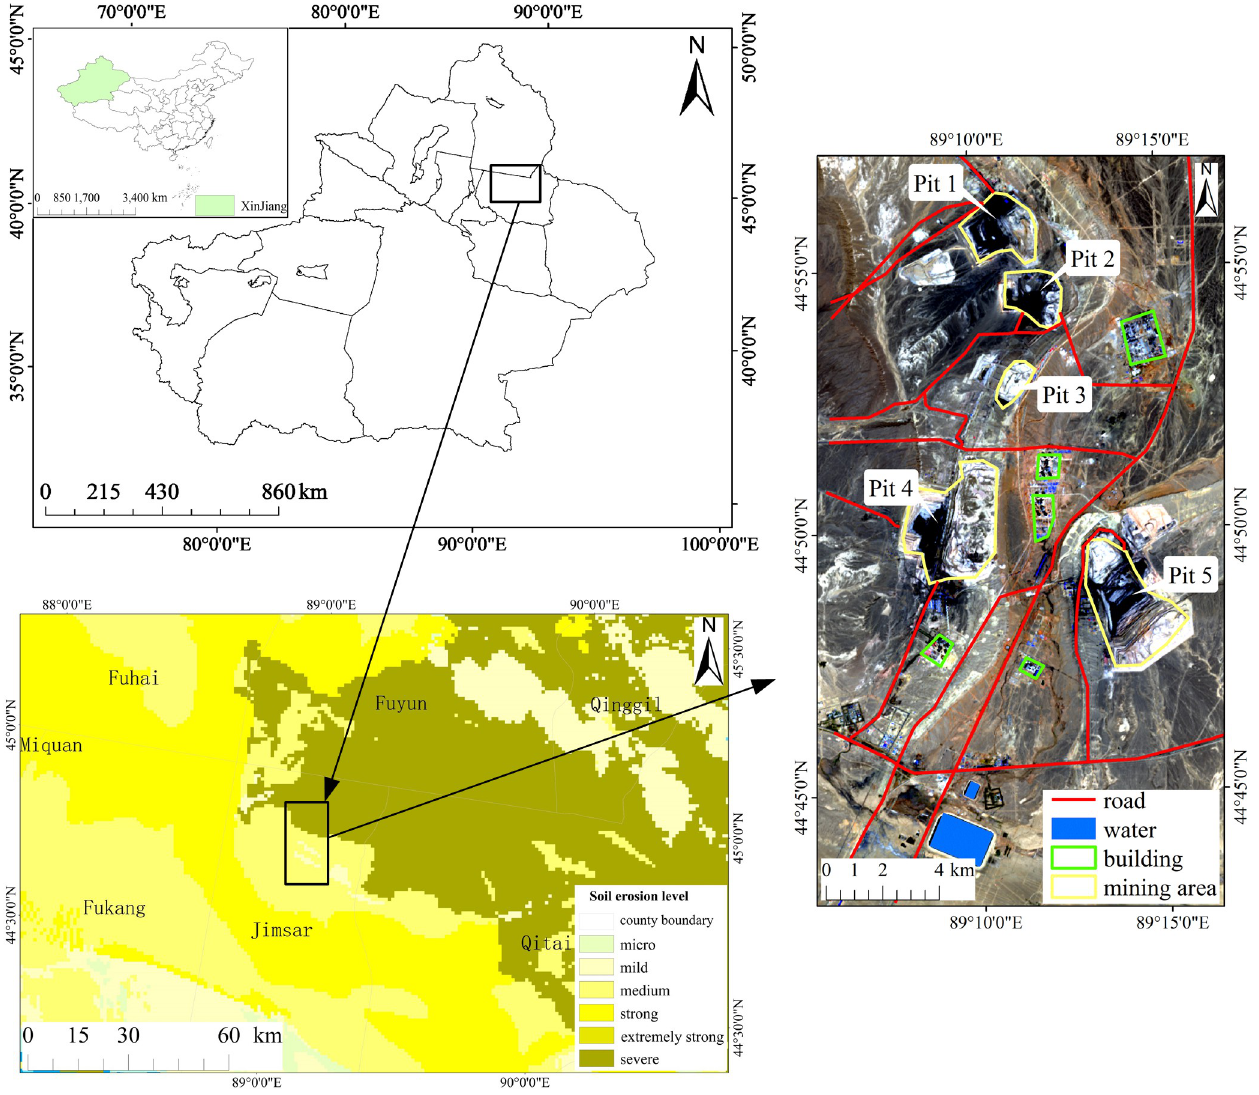
Fig 1. Map showing the location of the study